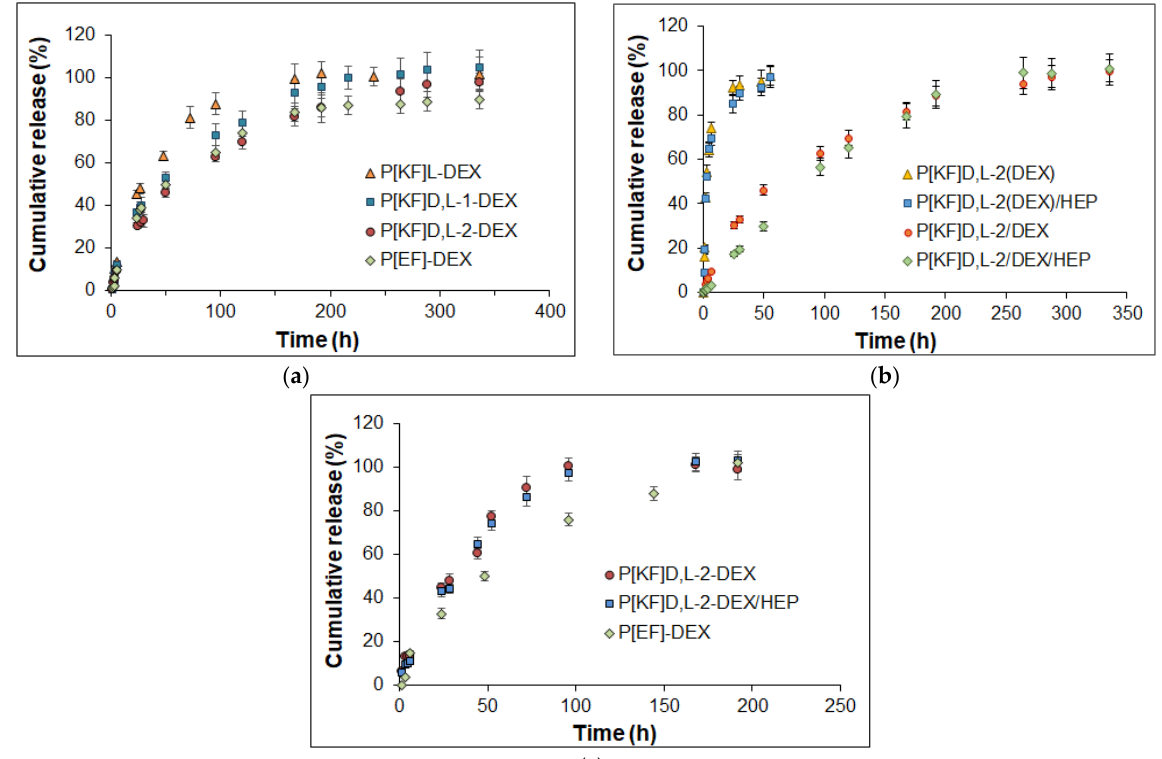
Figure 11. DEX release profiles from the various delivery systems: lysine- and glutamic acid-based conjugates in PBS ( a ), heparin-covered and non-covered lysine-based conjugates (P[KF] D,L -2/DEX/HEP and P[KF] D,L -2/DEX) and encapsulated nanoparticles (P[KF] D,L -2(DEX)/HEP and P[KF] D,L -2(DEX)) in 0.01 M PBS (pH 7.4) ( b ), and lysine- and glutamic acid-based conjugates in the vitreous/PBS mixture (50/50, v/v ) ( c ) (incubation at 37 °C).